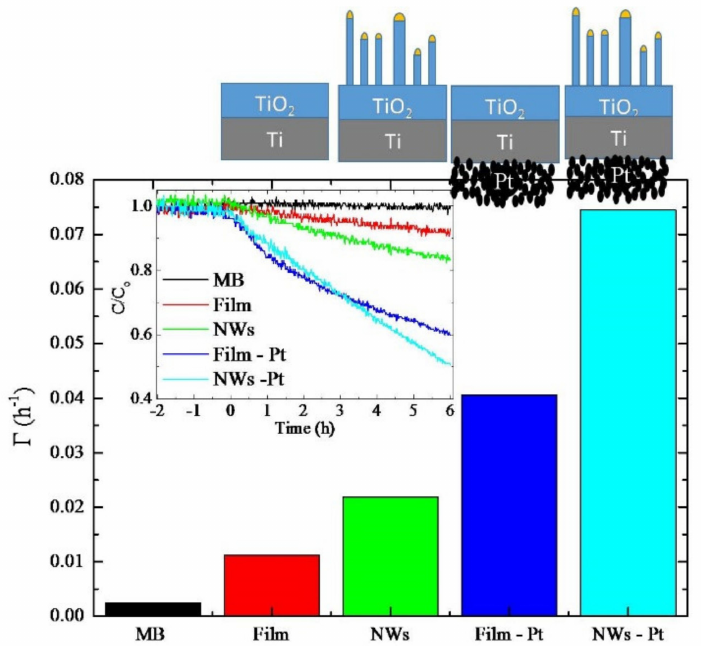
Figure 5. Photocatalytic activity of different samples: MB (without any catalyst), film, TiO 2 NWs, film with Pt, and NWs with